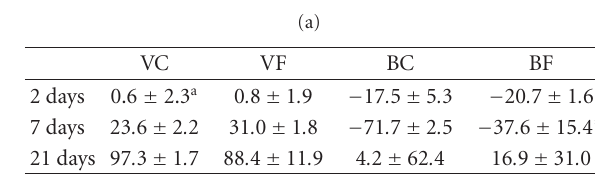
Table 1: (a) Body weight gain or loss shown by experimental group after bleomycin treatment. (b) Food intake averages by experimental group after bleomycin